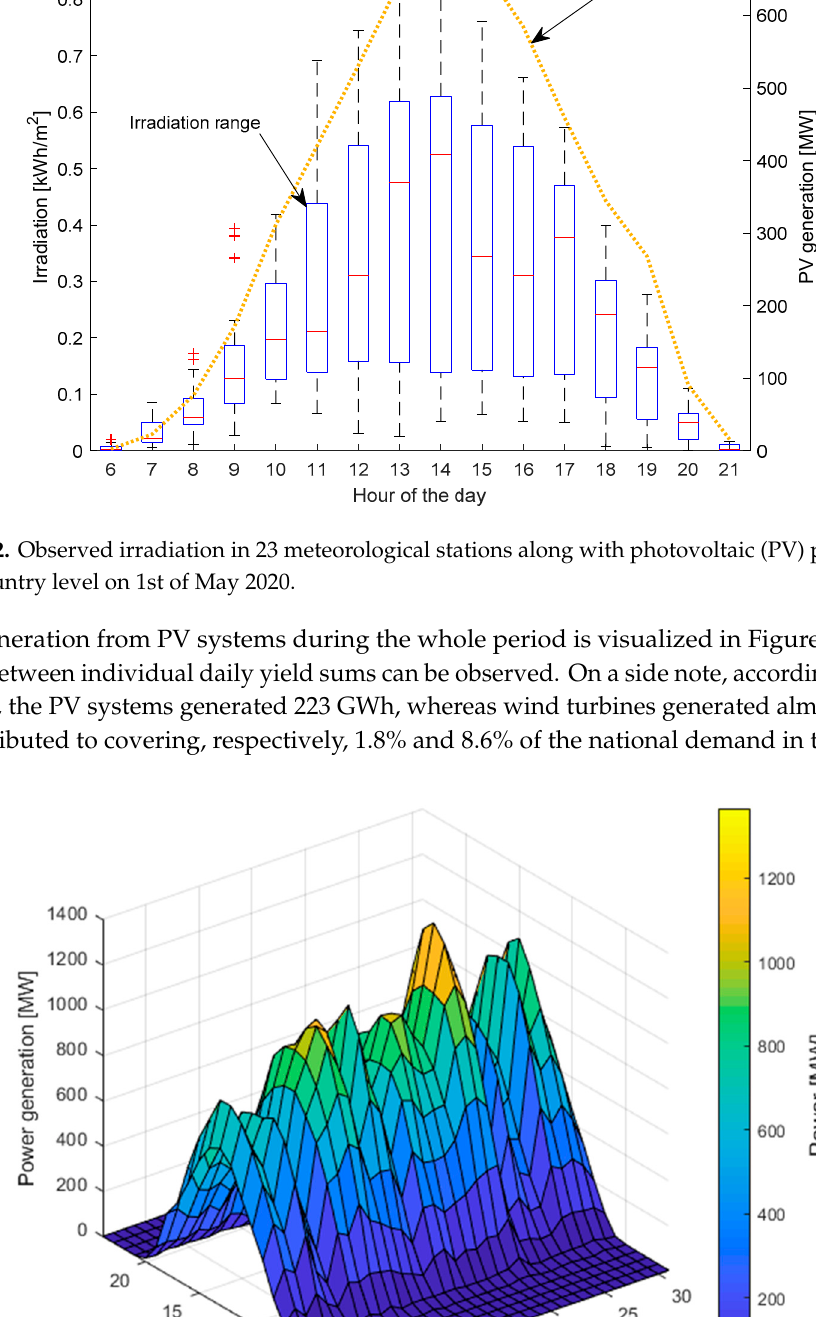
Figure 4. Performance of neural networks for the testing subset based on mean absolute percentage error (MAPE) criteria. 0